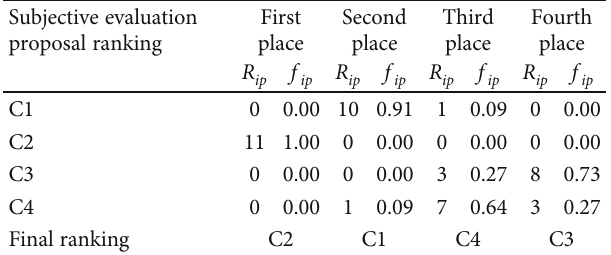
3 : 189 1 : 914 1 : 321 Þ .